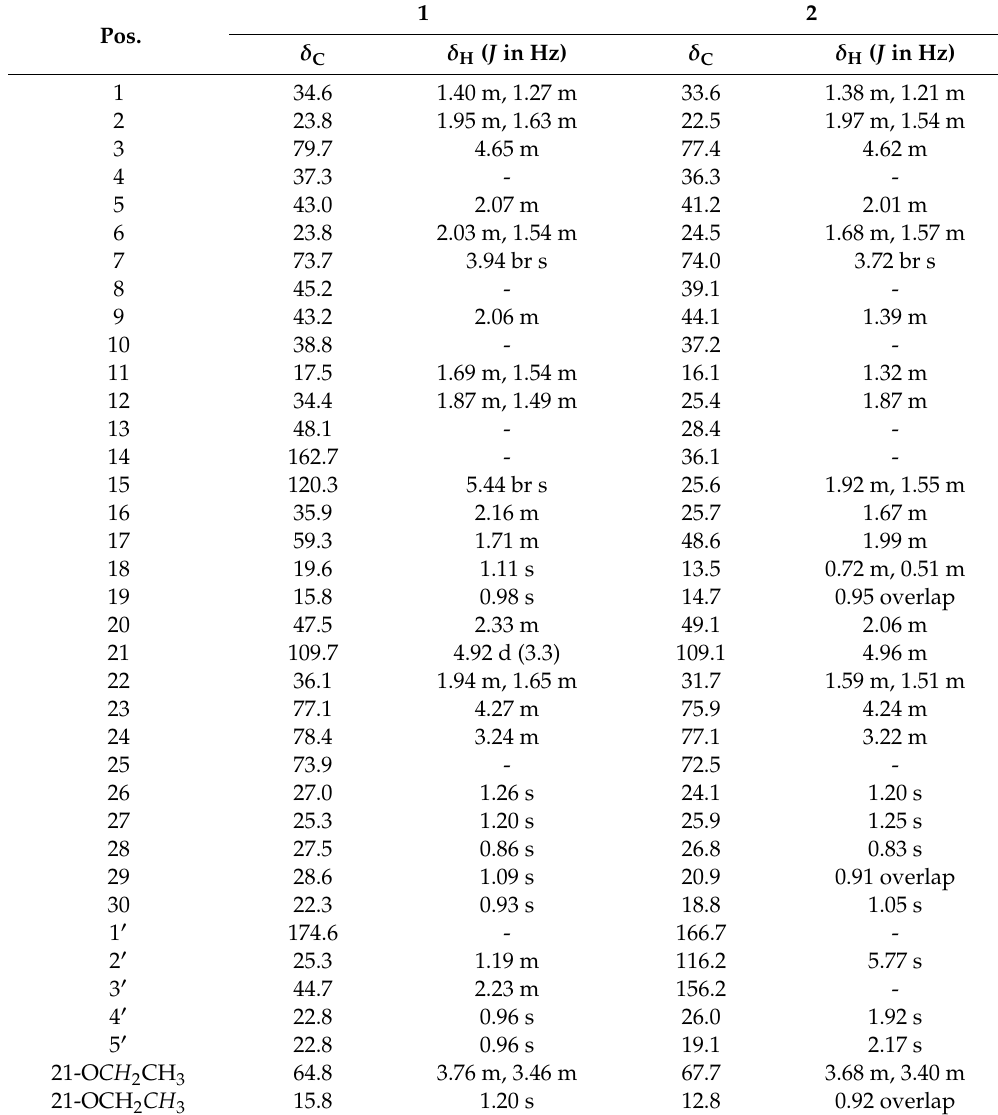
Table 1. The 1 H- and 13 C-NMR data (500 and 125 MHz) of compounds 1 and 2 ( δ in ppm) in methanol- d 4.